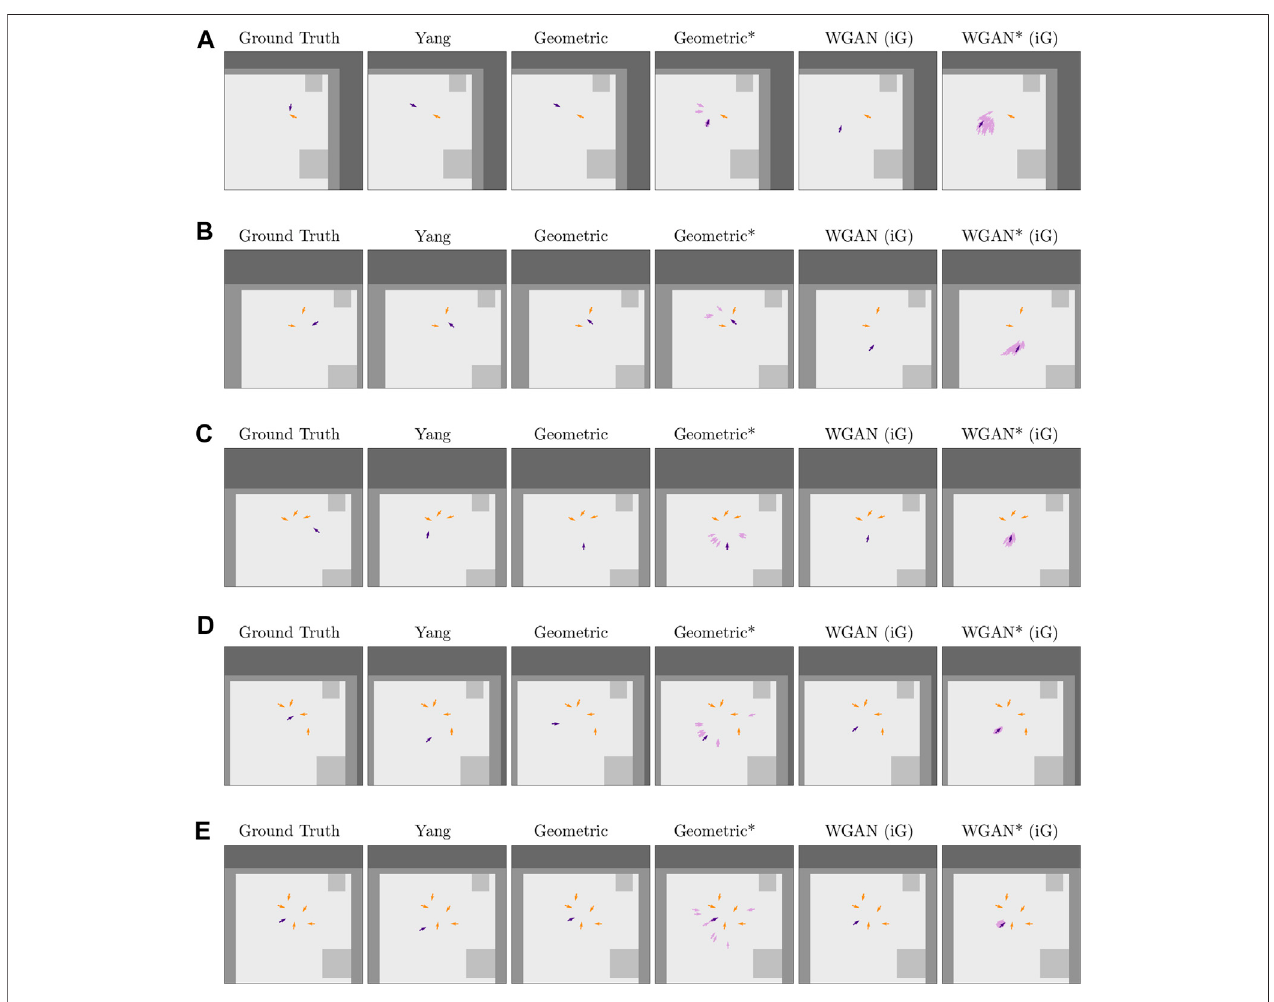
FIGURE 6 | Successful predictions for several methods (one per column) on fi ve different problems (rows) from the Cocktail Party test set. The orange arrows correspond to the poses in the context C , and the purple arrows are predicted poses, except for the Ground Truth column in which the purple arrows correspond to a trueposebyagroupmember.Notethatthedarkerpurplearrowsarethe fi naloutputbyeachmethod,andthelighteronesareadditionalpredictionsbythemethodsthat computedadistributionofposes.Thecolorsoftheenvironmentmaparethesameasin Figure5C : “ freespace ” islightgray, “ shortobstacles ” ismedium-intensity gray, and “ tall obstacles ” is darker gray. In addition, these plots show one more label for “ unknown ” occupancy (darkest gray color). The latter label was a result of croppingthefullenvironmentmaparoundcontextposesnexttotheedgeofthemap.Whencomputingresults, “ unknown ” occupancywasconsideredasnonfreespace by the Geometric approach and was aggregated with tall obstacles for the WGAN. This Figure is best viewed in color.